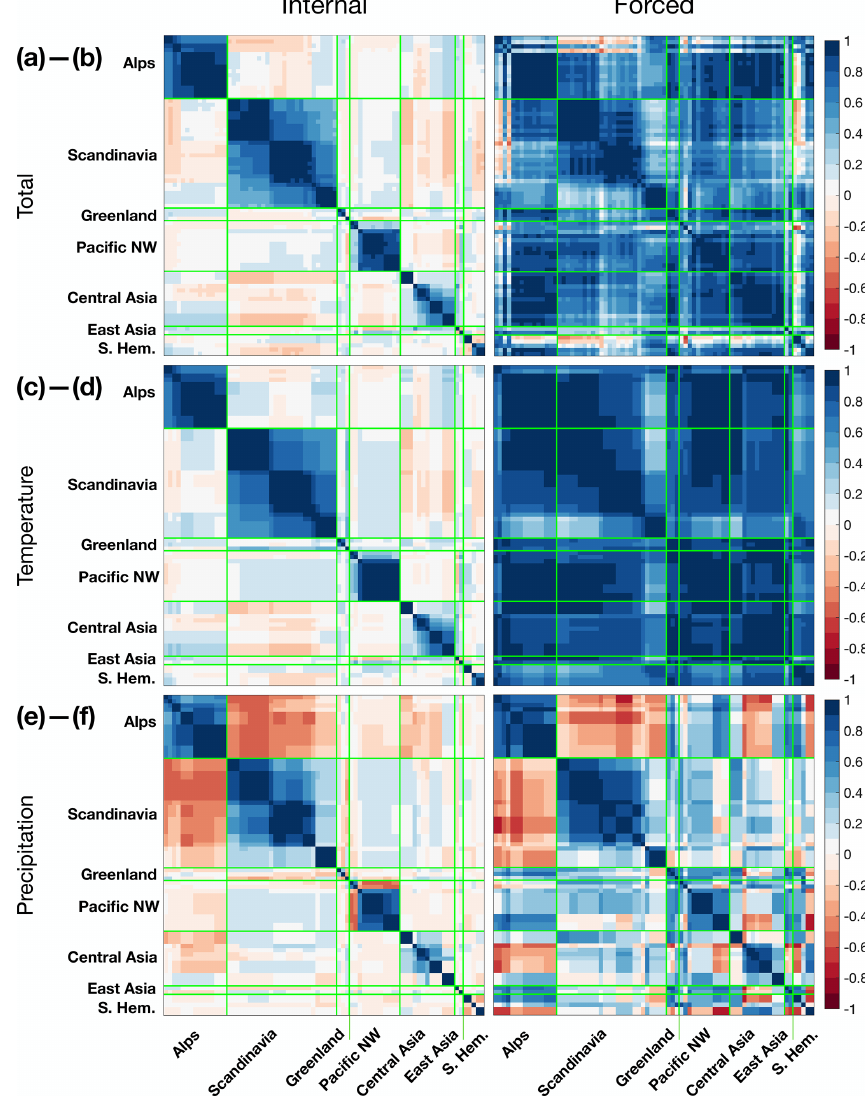
Figure 5. Matrix of cross correlations among the network of 76 glacier locations (Table A1), grouped by region. Each column or row in the matrix shows the correlation coefficients of glacier length at one location with glacier length at every other location in the network, calculated for the pre-industrial era (1000 to 1880). Left panels show results for internal variability, and the right panels shows results for forced variability. Top row shows the results for the full mass-balance variability, while the middle and bottom rows show results for, respectively, the temperature-only and precipitation-only components of the mass balance. Blue colors indicate positive correlations, and red colors indicate negative correlations. A response time of τ = 10 years was used for these